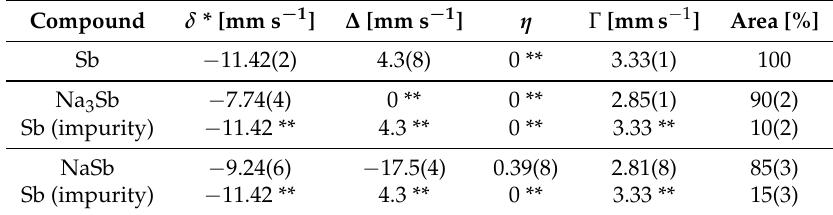
Table 1. 121 Sb hyperfine parameters at 78K for Sb and the Na-Sb intermetallics.